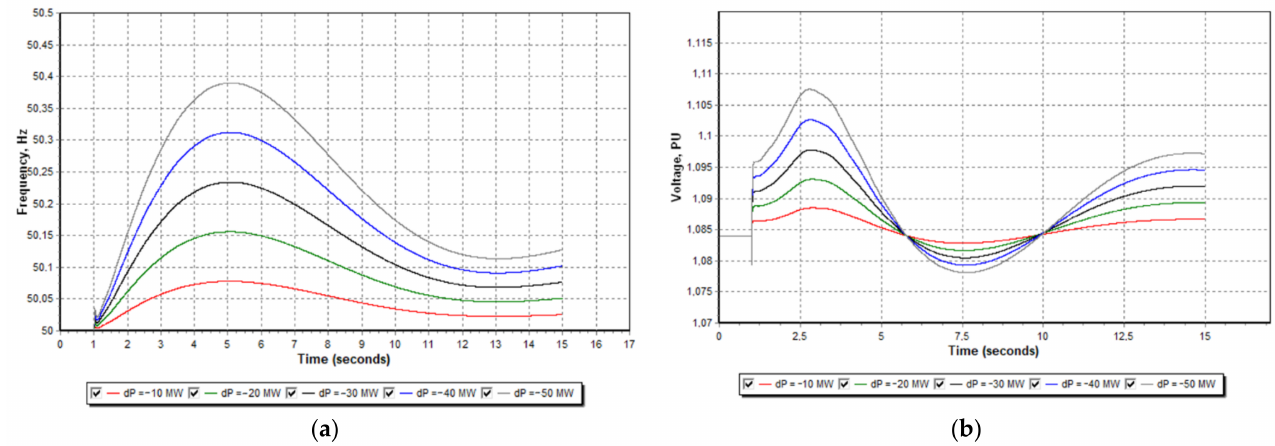
Figure 8. ( a ) Frequency change in the isolated power system caused by a load decrease (case A). ( b ) Voltage fluctuations on the 330 kV side caused by a load decrease (case A).